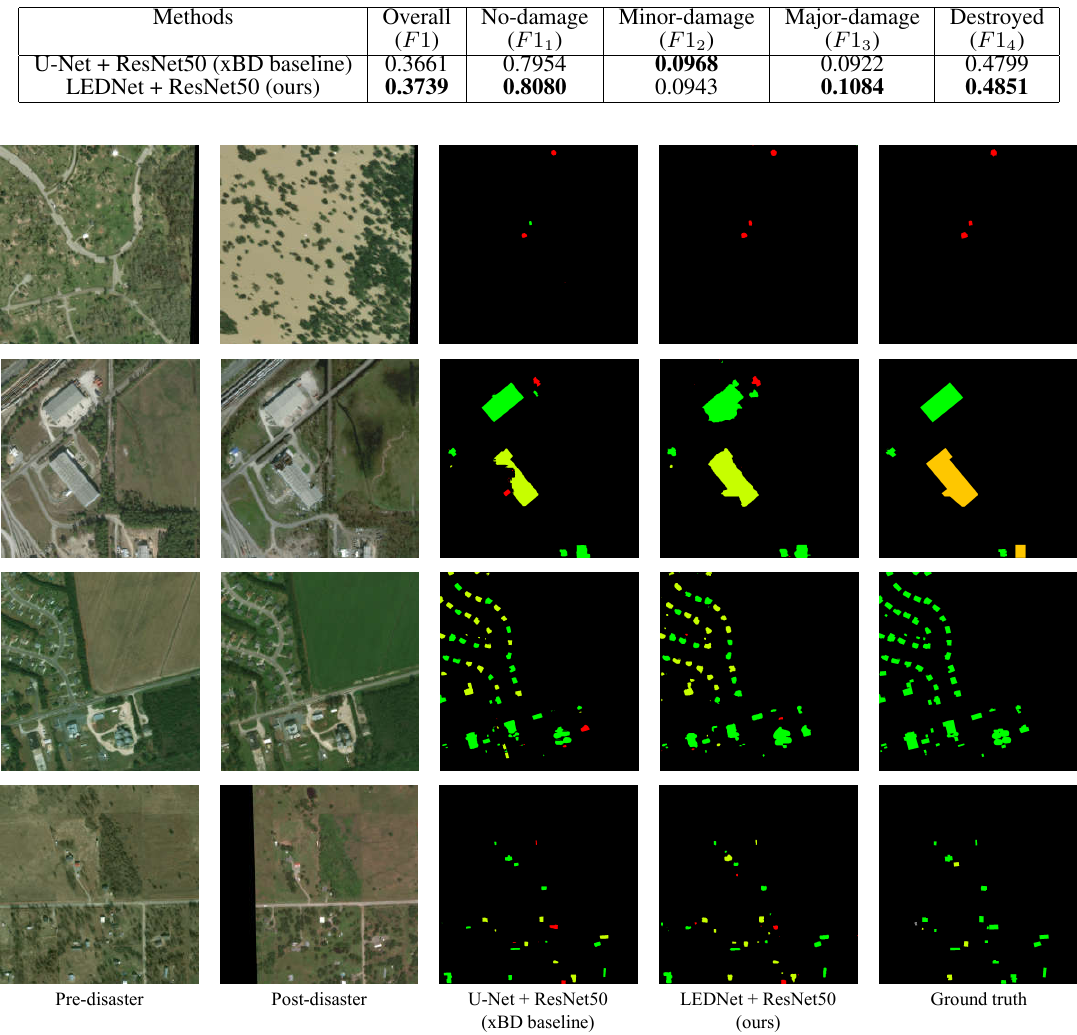
Table 2. Quantitative evaluation for buildings damage assessment.